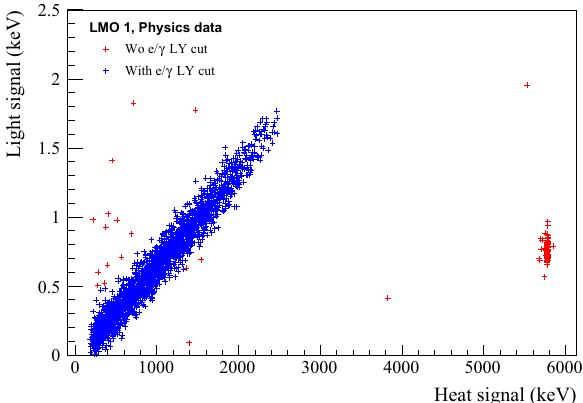
Fig. 15 Light yield versus heat signal scatter-plot using 11 days of physics data from LMO 1. The presented detector has the highest 210 Po contamination to illustrate best the distributions of α and γ events and the scintillation light quenching for α